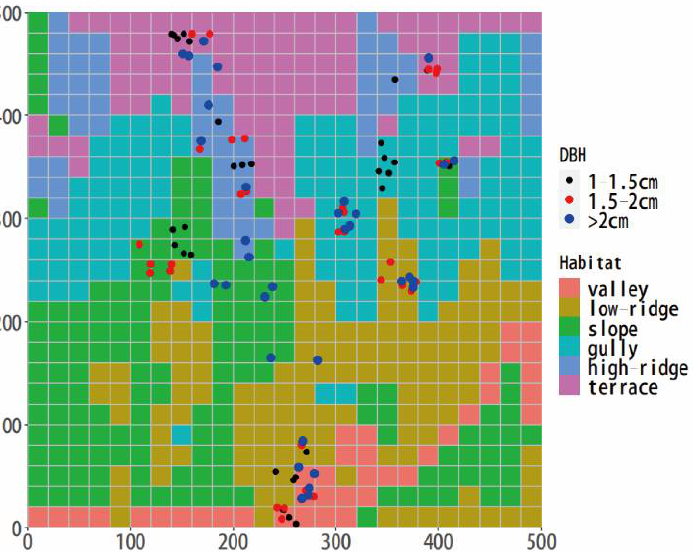
Figure 1. Distribution of sampling sites of L. fragrantissima var. lancifolia in the Qinling Huangguan plot.